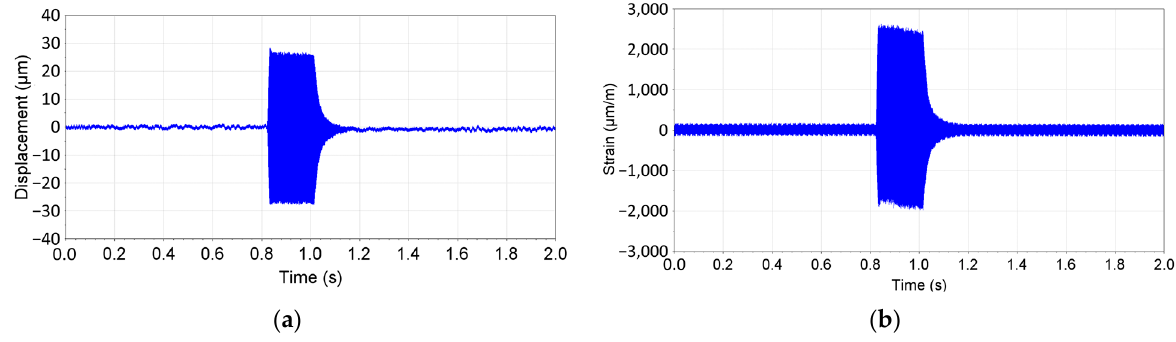
Figure 10. Displacement and strain measurement, UHCF S690 specimen, maximum displacement amplitude of 26.8 μ m: ( a ) Displacement over time; ( b ) Strain over time.